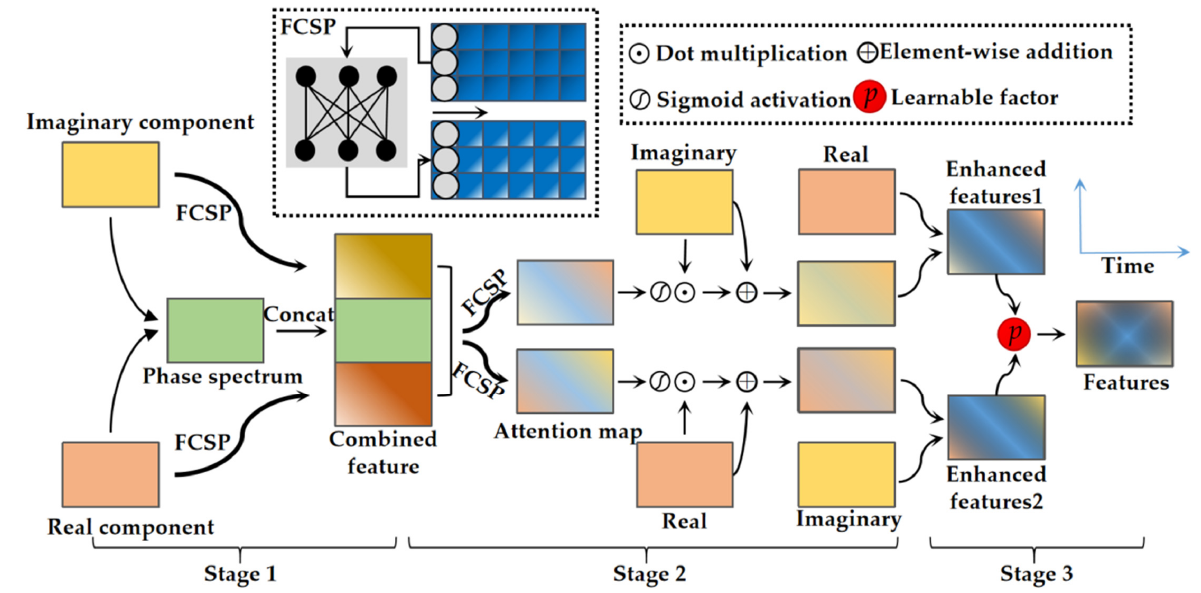
Figure 6. The schematic diagram of TFA-ATNN.